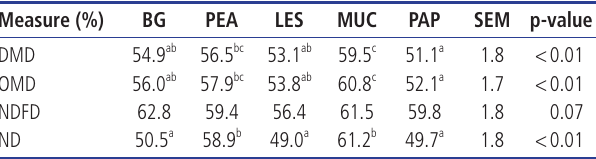
SEM, standard error of the least squares means. a-c Means within a row with different superscripts differ (p<0.05).